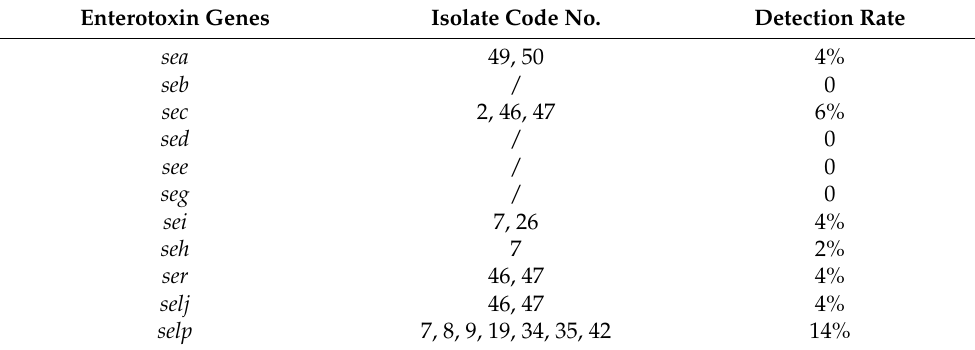
Table 4. Distribution of enterotoxin